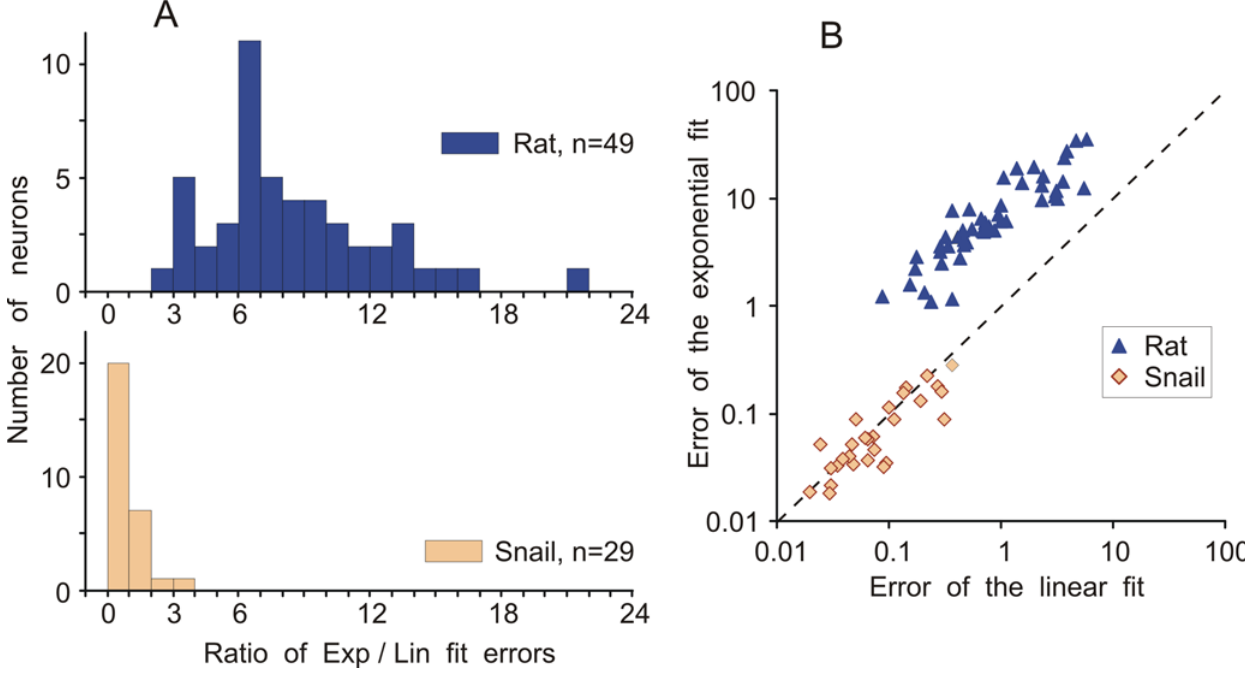
Figure 2. Population analysis: Ratio of the errors of exponential fit over the piecewise-linear fit for rat and snail neurons. A: Distributions of the ratio of errors of the exponential fit and piecewise-linear fit of the initial part of APs for 49 rat neocortical neurons and 29 snail neurons. B: Scatter plot of the error of exponential fit against the error of the piecewise linear fit for the neurons from A. Notice double-logarithmic scale. Each point represents data for one neuron. Colour code is the same in A,B.